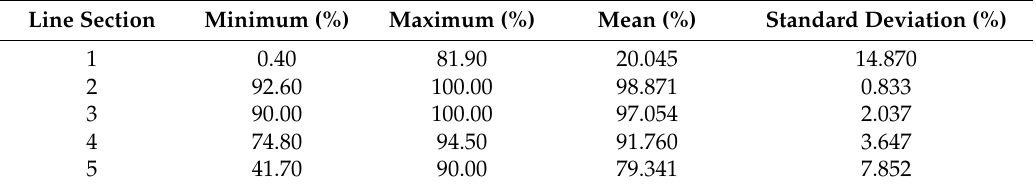
Table 2. Packet Success Rate (PSR) Probability Distribution Function (PDF) of each line